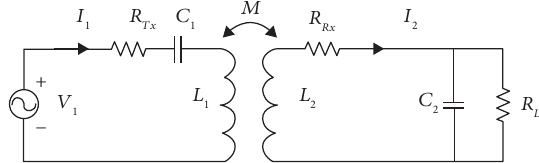
Figure 2: The illustration of the circuit model for an inductive link power transfer